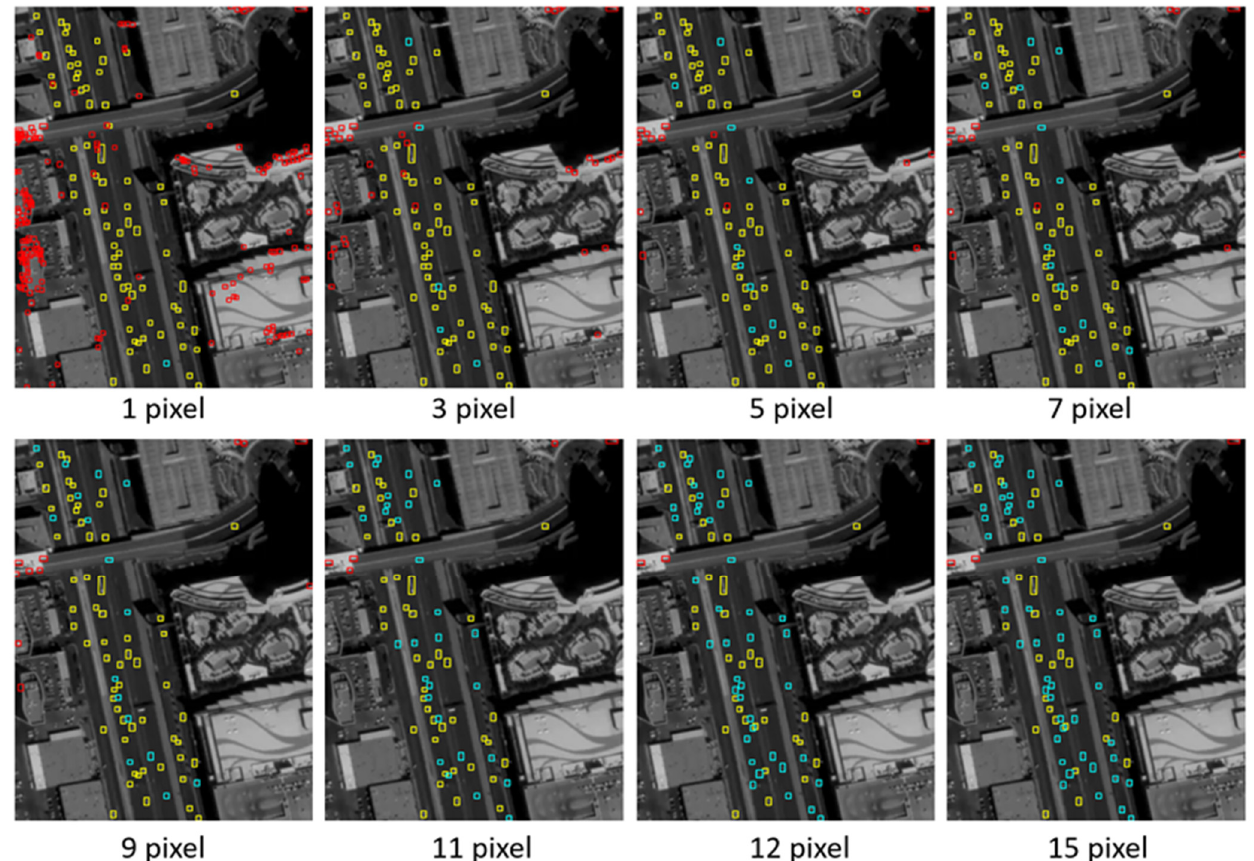
Figure 14. Noise removal of NPBSM detection results under different area thresholds: yellow indicates correct targets, red shows false targets, and cyan depicts missed targets. Table 3. Evaluation under different area thresholds.